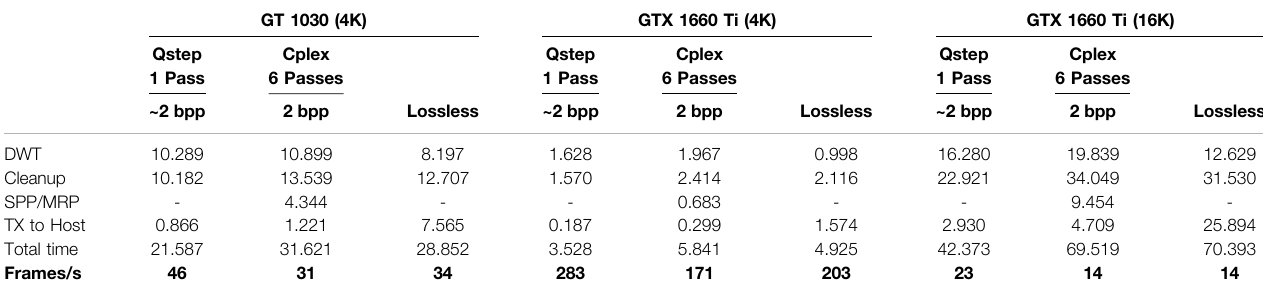
TABLE 2 | Time (in milliseconds) consumed by different CUDA kernels for encoding 4K and 16K video frames. The “ Total time ” includes the time needed by additional kernels, not discussed here. The bottom row shows achievable frame